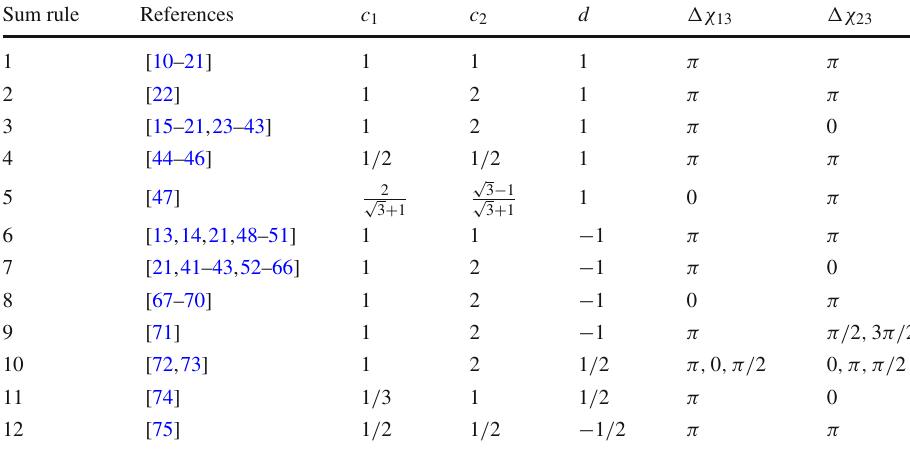
Table 1 Summary table of the sum rules present in the literature. The parameters c 1 , c 2 , d ,(cid:3)χ 13 , and (cid:3)χ 23 , which characterise them, are defined in Eq. (1.1). In sum rules 9 and 10 two possible signs appear which lead to two possible values of (cid:3)χ i